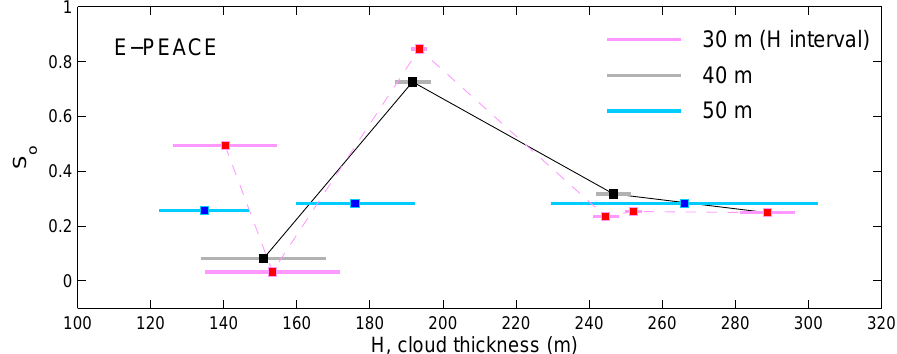
Figure C1. S o is calculated with cloud data that are averaged over an e -folding time for E-PEACE. S o calculated with three H intervals ( (cid:49) 30m, (cid:49) 40m, and (cid:49) 50m) is shown. Horizontal bar indicates ± 1 σ cloud thickness for a given H